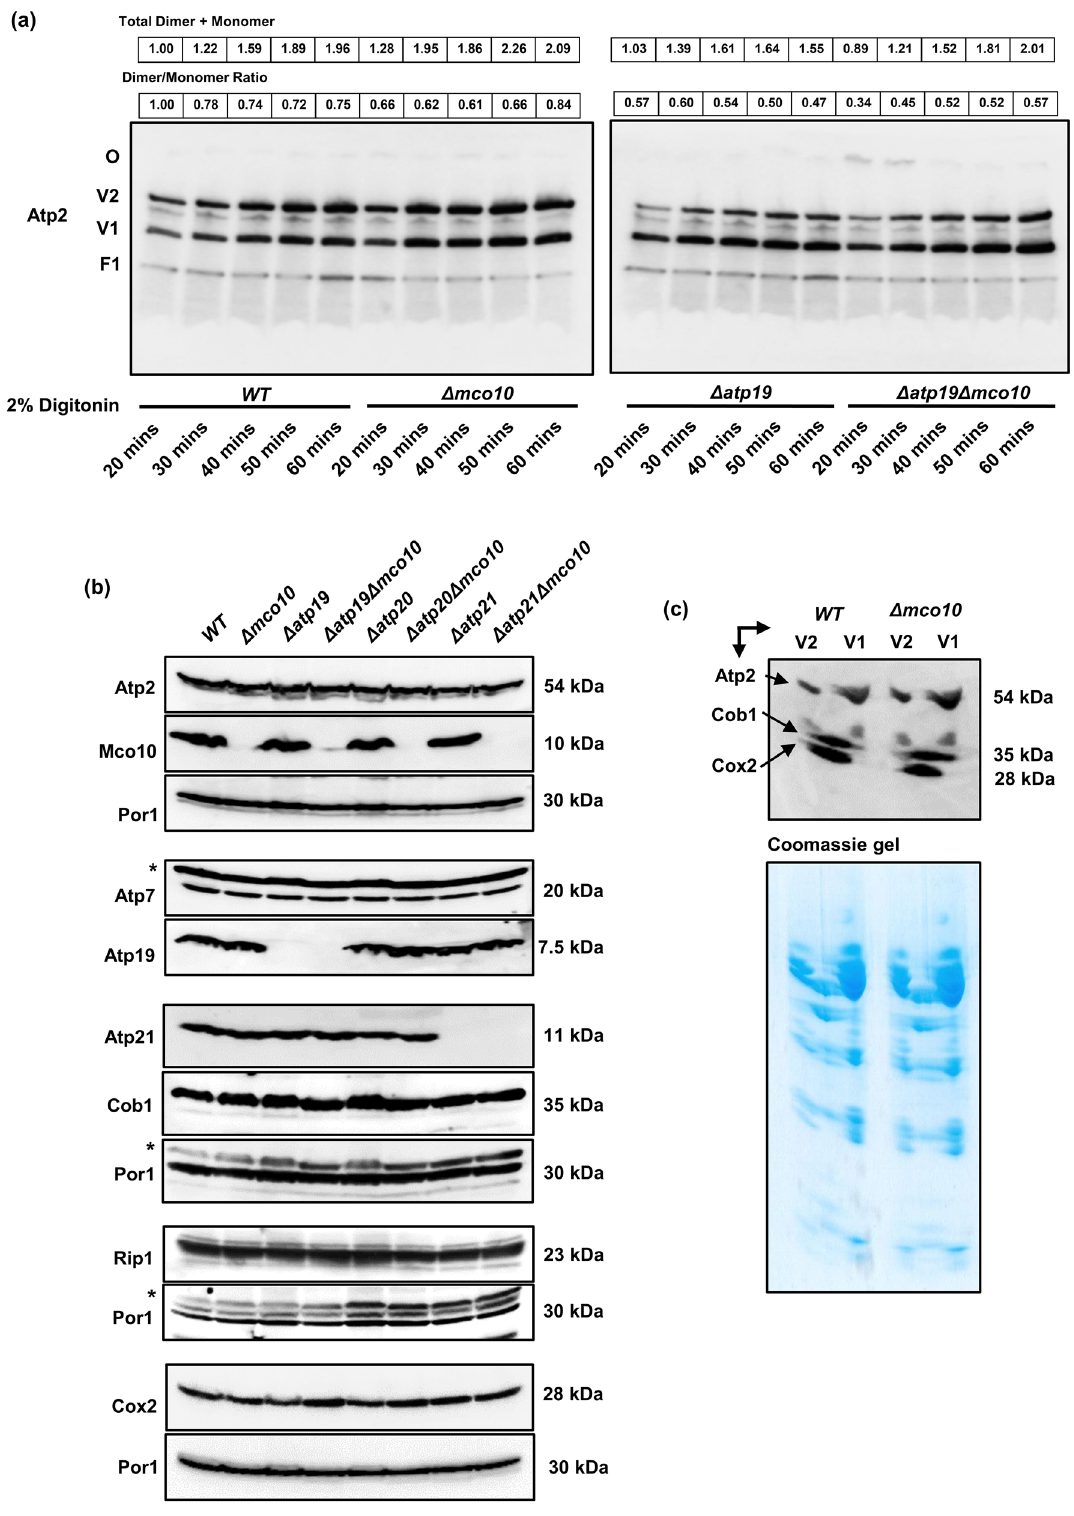
Figure 5. Mco10 deletion makes ATP synthase more susceptible to digitonin extraction. ( a ) BN-PAGE analysis of ATP synthase complexes extracted from 500 µg of mitochondria by incubation in extraction buffer containing 2% digitonin for indicated time. The dimers (V2), monomers (V1) and free F1 domain are visualized by western blot using anti-Atp2 antibody. The total amount of dimers and monomers as well as the dimers/monomers ratios are indicated above the gels. Original blots/gels are presented in SupplementaryRowImages page 2. ( b ) Western blot analysis of ATP synthase, complex III and complex IV subunits in total protein extracts from Δmco10 , Δatp19 , Δatp20 , Δatp21 and corresponding Δmco10 double mutants grown in YPGlyA medium. Non-specific bands are indicated with the stars. Por1 protein level is shown as loading control. Original blots/gels are presented in SupplementaryRowImages pages 3–6. ( c ) Complex III, IV and ATP synthase subunits abundance in two-dimensional gel electrophoresis after digitonin extraction. The lower panel shows the Coomassie stained second dimensional denaturing gels. Original blots/gels are presented in SupplementaryRowImages page 7.The representative gels are